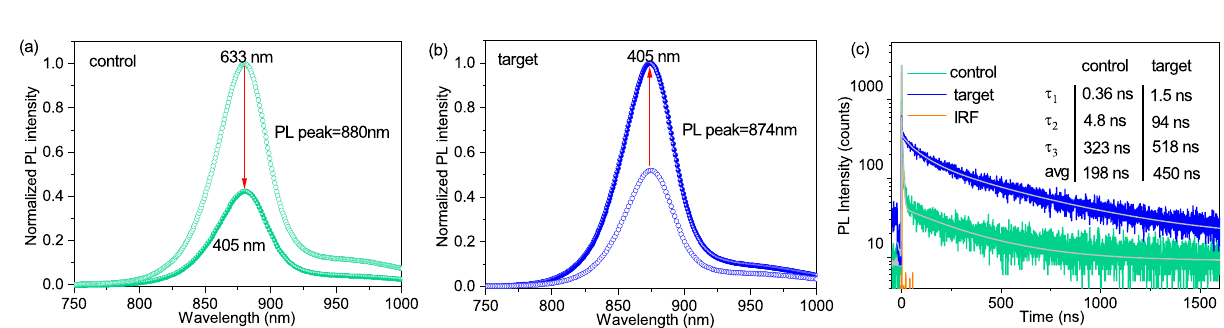
Fig. 3 | Reduced recombination due to the presence of Cd(O,S,Se,Te) region. a Steady-state PL spectra with different excitation beam wavelengths (405 and 633nm) entering from the glass side for the ( a ) control and ( b ) target devices. c Time-resolved PL (TRPL) and the corresponding 3-exponential fi tting curves for